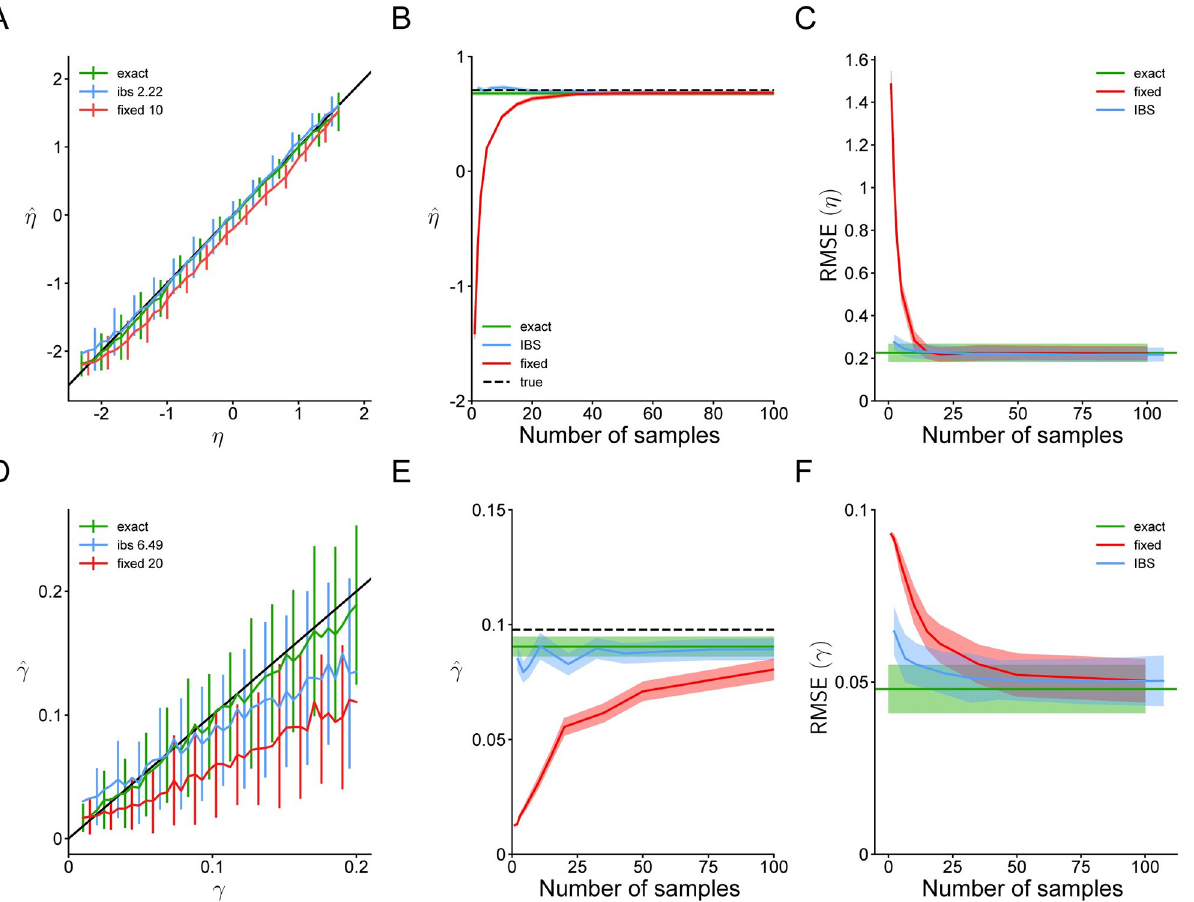
Fig 5. Parameter recovery for the orientation discrimination model. A . Estimated values of η � log σ as a function of the true η in simulated data using IBS with R = 1 repeat (blue), fixed sampling with M = 10 (red) or the exact likelihood function (green). The black line denotes equality. Error bars indicate standard deviation across 100 simulated data sets. IBS uses on average 2.22 samples per trial. B . Mean and standard error (shaded regions) of estimates of η for 100 simulated data sets with η true = log 2˚, using fixed sampling, IBS or the exact likelihood function. For fixed sampling and IBS, we plot mean and standard error as a function of the (average) number of samples used. C . Root mean squared error (RMSE) of estimates of η , averaged across the range of η true in A , as a function of the number of samples used by IBS or fixed sampling. Shaded regions denote ± 1 standard deviation across the 100 simulated data sets. We also plot the RMSE of exact maximum-likelihood estimation, which is nonzero since we simulated data sets with only 600 trials. D-F Same, for γ (with R = 3, M = 20 in panel D ). These results demonstrate that IBS estimates parameters of the model for orientation discrimination more accurately than fixed sampling using equally many or even fewer samples.